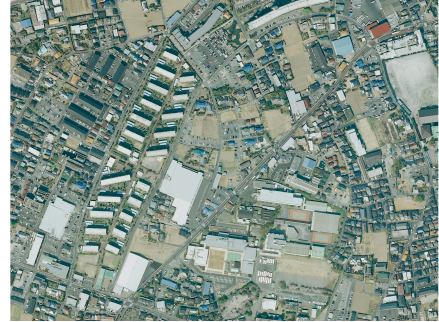
Figure 1. Aerial images in Saitama District year 2007